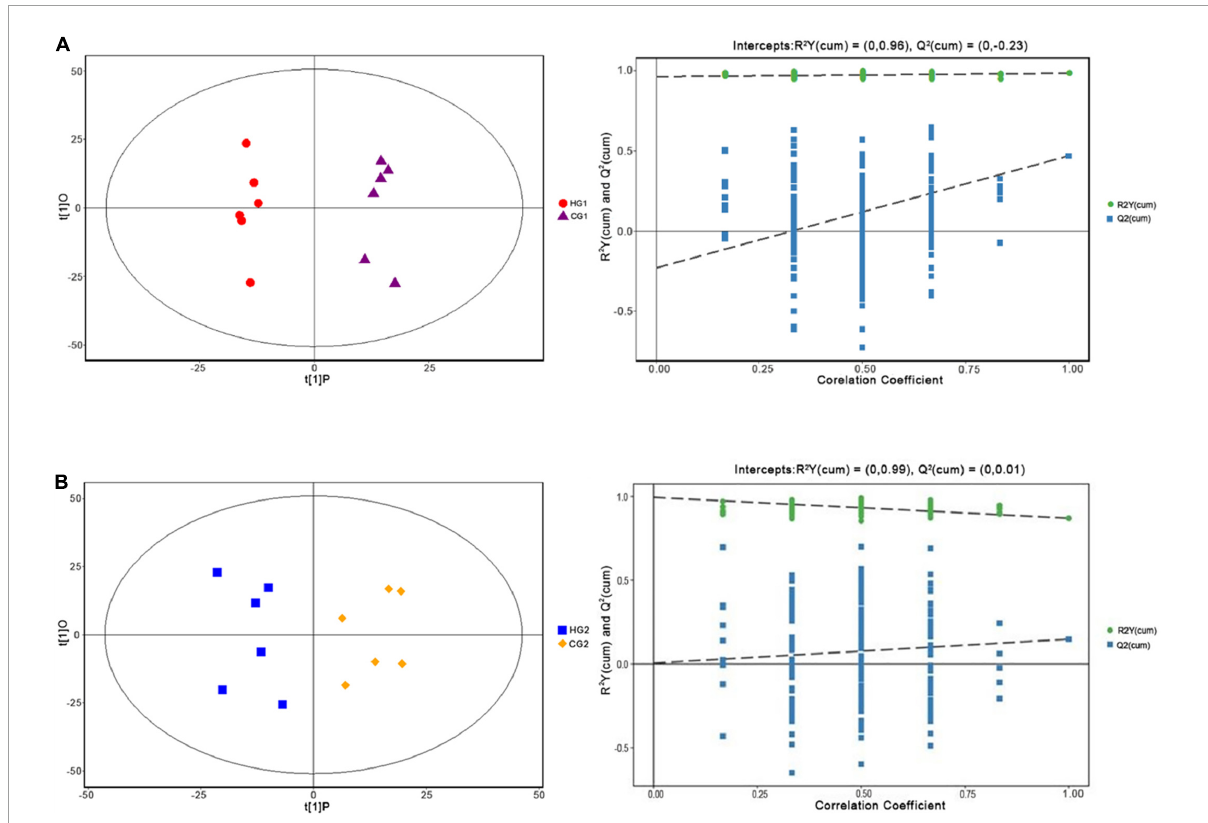
FIGURE4 Orthogonal partial least squares discriminant analysis (OPLS-DA) plot of plasma metabolites of Ira rabbits supplied with C. butyricum at 53 days of age (A) and 67 days of age (B)